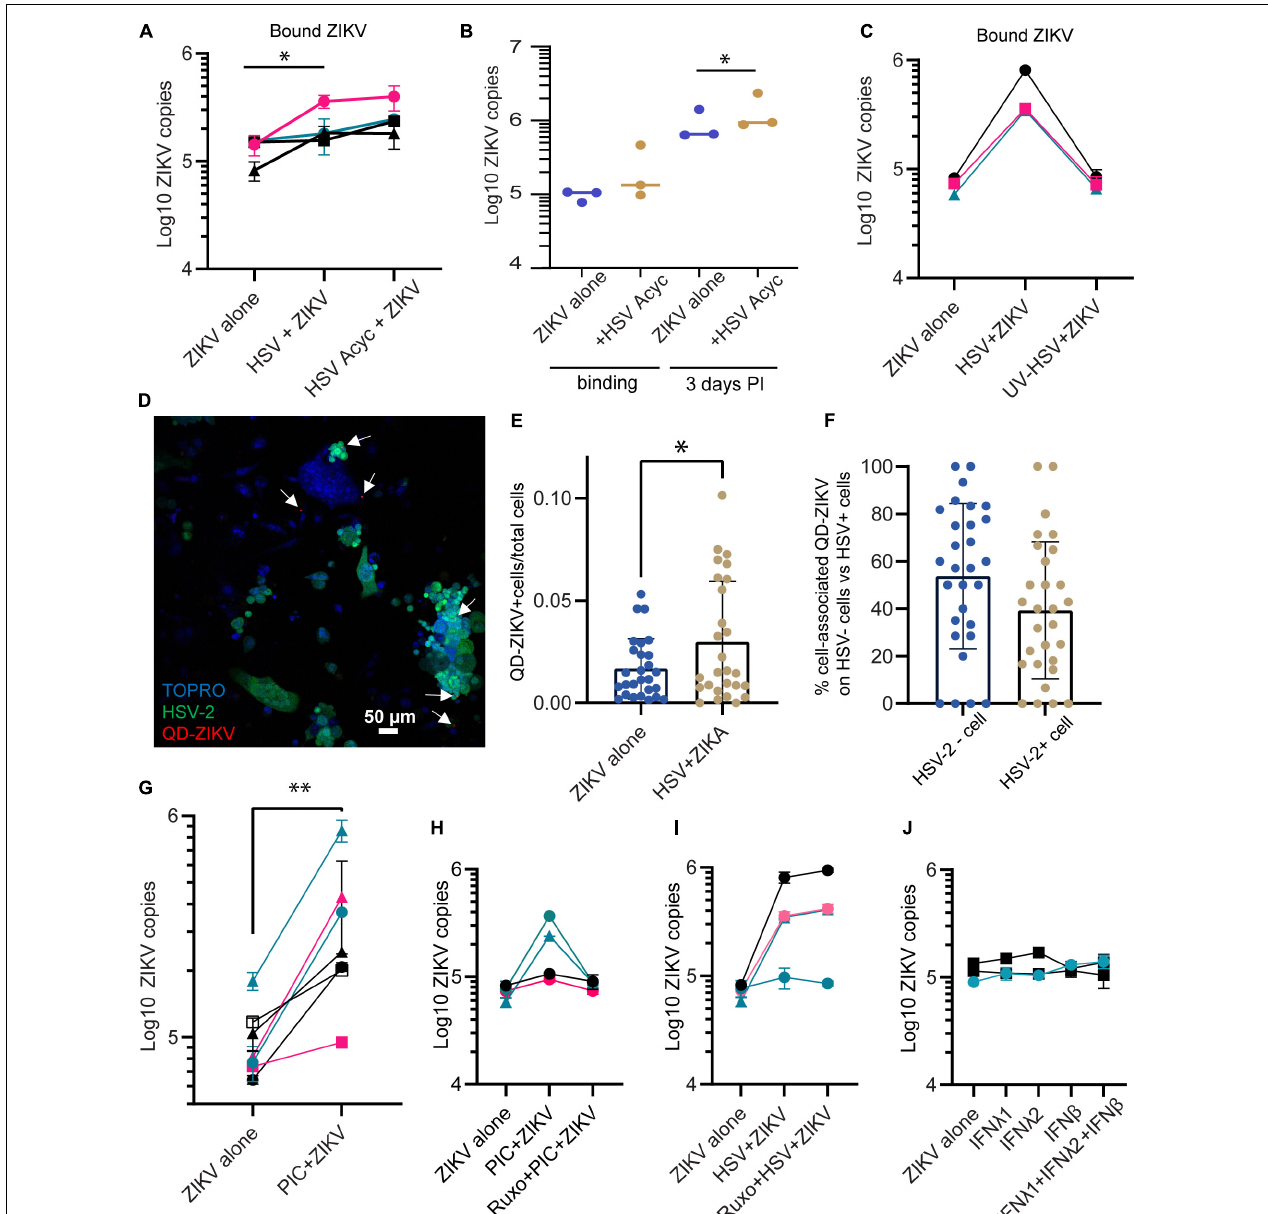
FIGURE 2 | Enhanced binding by ZIKV does not require HSV-2 replication. (A) Adding acyclovir at the time of HSV-2 infection still leads to enhanced ZIKV binding. Epithelial cells were mock-treated or pre-infected with HSV-2 strain 186 (MOI 0.1), in the presence or absence of ACV. ZIKV binding was evaluated 24 h post HSV-2 infection. In all plots, each symbol is a different cell line, and colors indicates tissue-of-origin: vaginal in black, ectocervical in teal, and endocervical in pink. P -value was calculated using paired t -test, p = 0.0164, N = 4 and is indicated by ∗ . (B) HSV-2+ acyclovir results in enhanced ZIKV replication. Epithelial cells were infected as in (A) , and lysed immediately (binding) or cultured for 72 h before lysing cells for ZIKV quantification. ∗ indicates significance, P value = 0.0233 by ratio paired t -test of viral genome copy numbers, N = 3. (C) UV-inactivated HSV-2 does not result in enhanced ZIKV binding. HSV-2 was treated with UV light or mock treated for 30 min prior to adding to cells. One day following exposure to UV-HSV, ZIKV was added for 1.5 h, then binding of ZIKV to cells was quantified. N = 3. (D) HSV-2 infection does not correlate with ZIKV binding on a per cell basis. Cells were infected with GFP-expressing HSV-2 strain 333 for 24 h. Then ZIKV virions chemically conjugated to QDs were added for 1.5 h to allow binding. Coverslip wells were washed 1 × with PBS, fixed, counterstained with TOPRO-3, and imaged. 10 frames per well were imaged. A representative image with GFP-expressing HSV-2 infected cells is shown; white arrows highlight QD signals. (E) QD-ZIKV is more frequently cell-associated in HSV-2 + cultures. Total number of QD-ZIKV per frame were counted and divided by the total TOPRO area as a measure of total number of cells. Number of QD/TOPRO area are plotted for each of 10 frames in 3 independent experiments. More cell-associated QD-ZIKV was detected in HSV-2 + cultures ( ∼ 2-fold more, p = 0.044 by t -test, indicated by *). Each dot represents a frame. (F) Within HSV-2 + cultures, cell-associated QD-ZIKV distributes equally between HSV-2 + and HSV-2 −